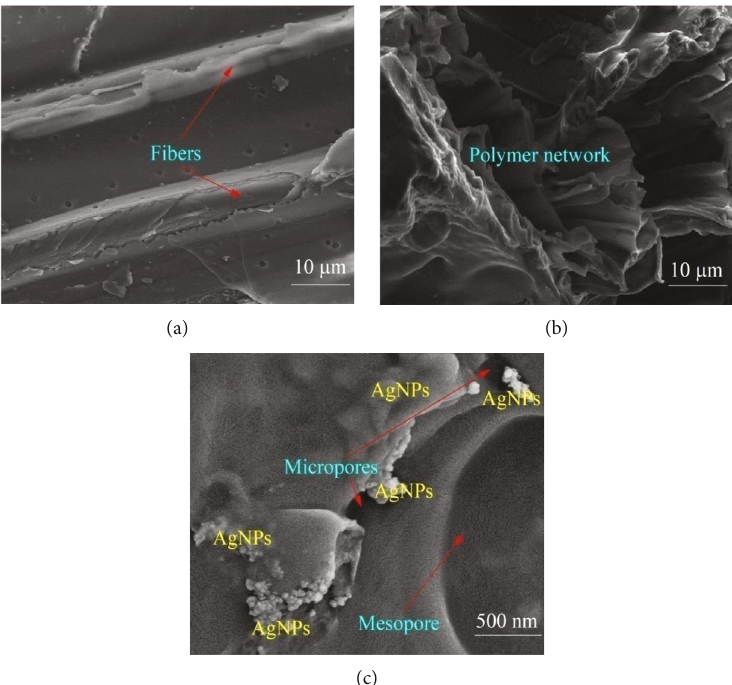
Figure 3: Scanning electron microscopy pictures present the morphology of (a) raw SB, (b) SB- β CD polymers, and (c) AgNP-SB- β CD nanocomposites.